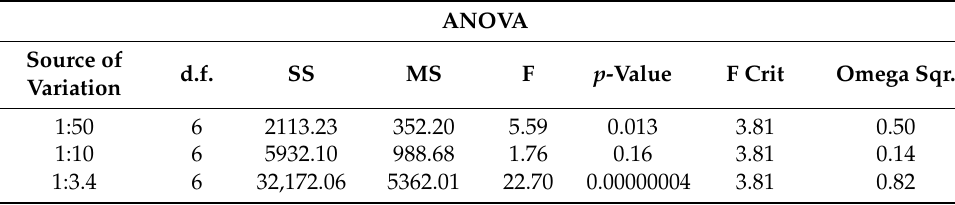
Table 6. The analysis of variance (one way) for all tested samples; the analyzed groups were exposed to different